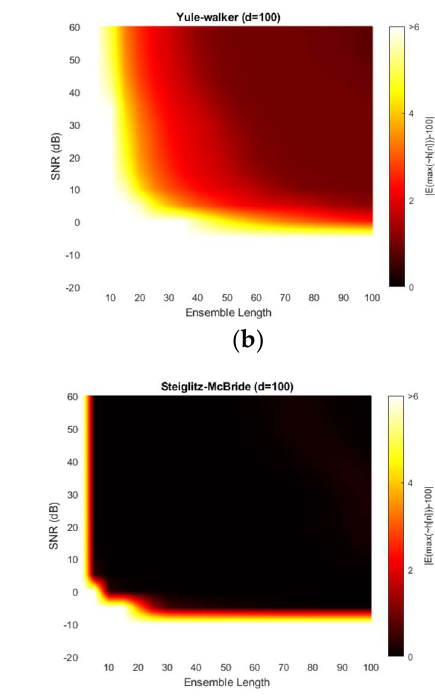
Figure 12. Variance of estimation with given ensemble average length & SNR for 50-sample delay: ( a ) non-parametric HD; ( b ) Yule-walker HD; ( c ) Prony HD; ( d ) Steiglitz-McBride HD.